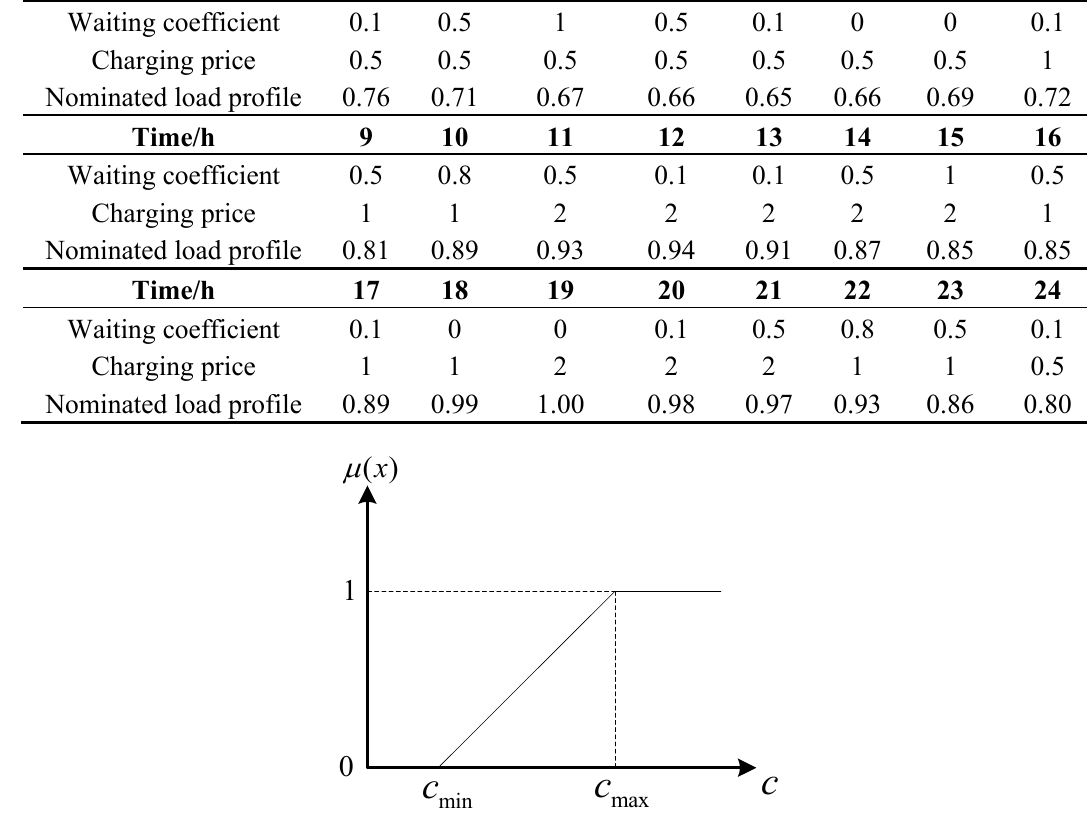
Figure 3. Membership function of